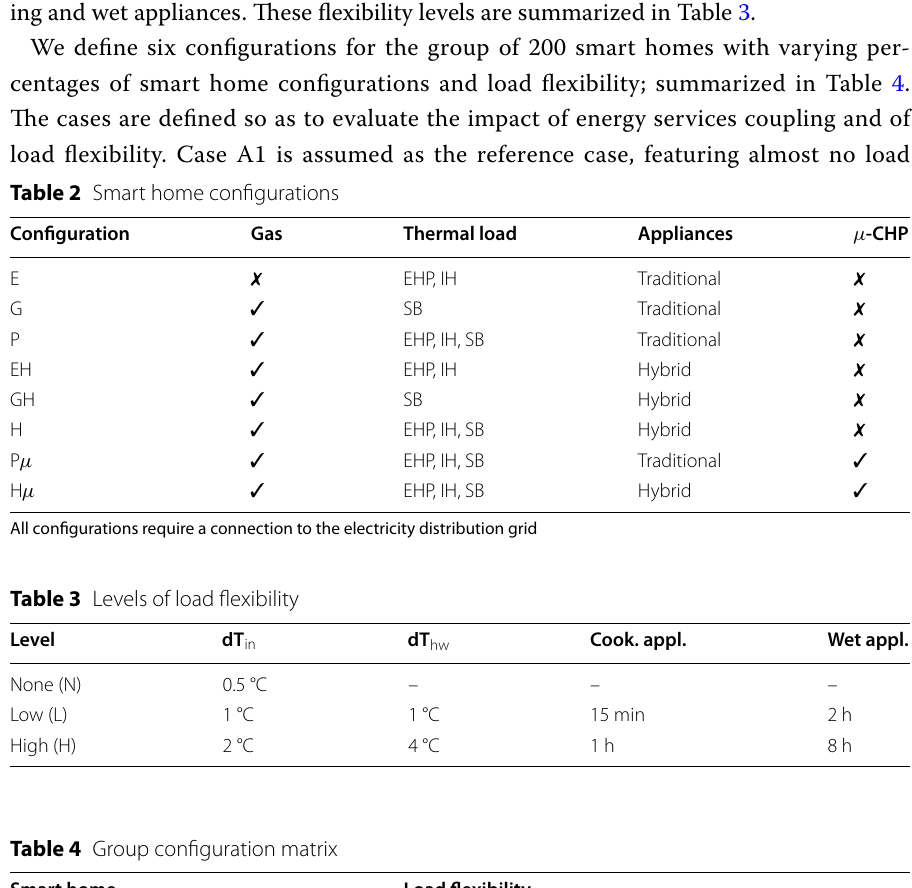
Table 4 Group configuration matrix Smart